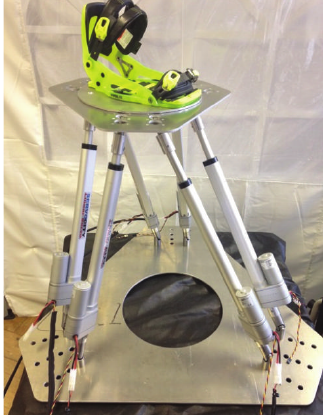
Figure 3: 6-DoF UPS parallel robot prototype built at the University of